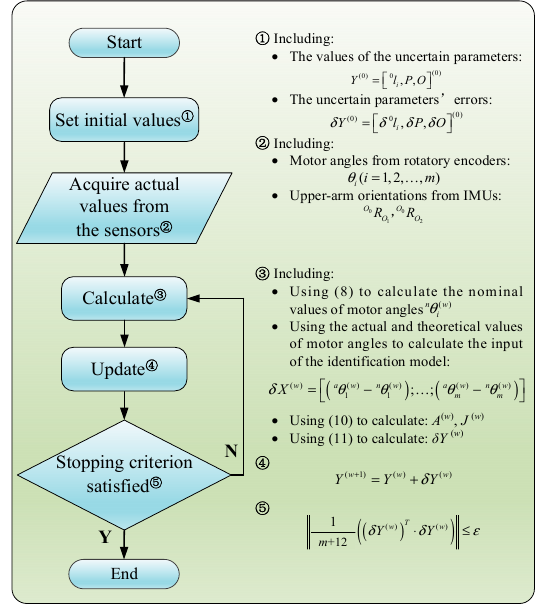
Figure 4. Flowchart of the identification of uncertain parameters.